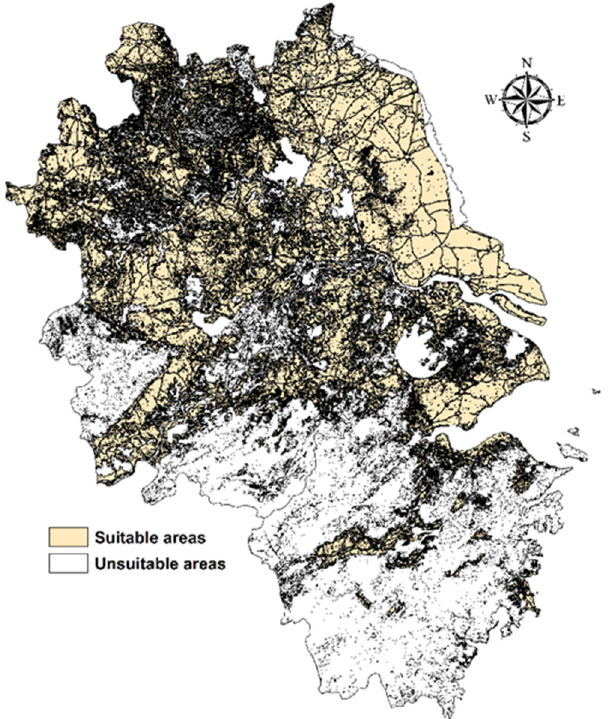
Figure 4. YRDR suitable and unsuitable areas.